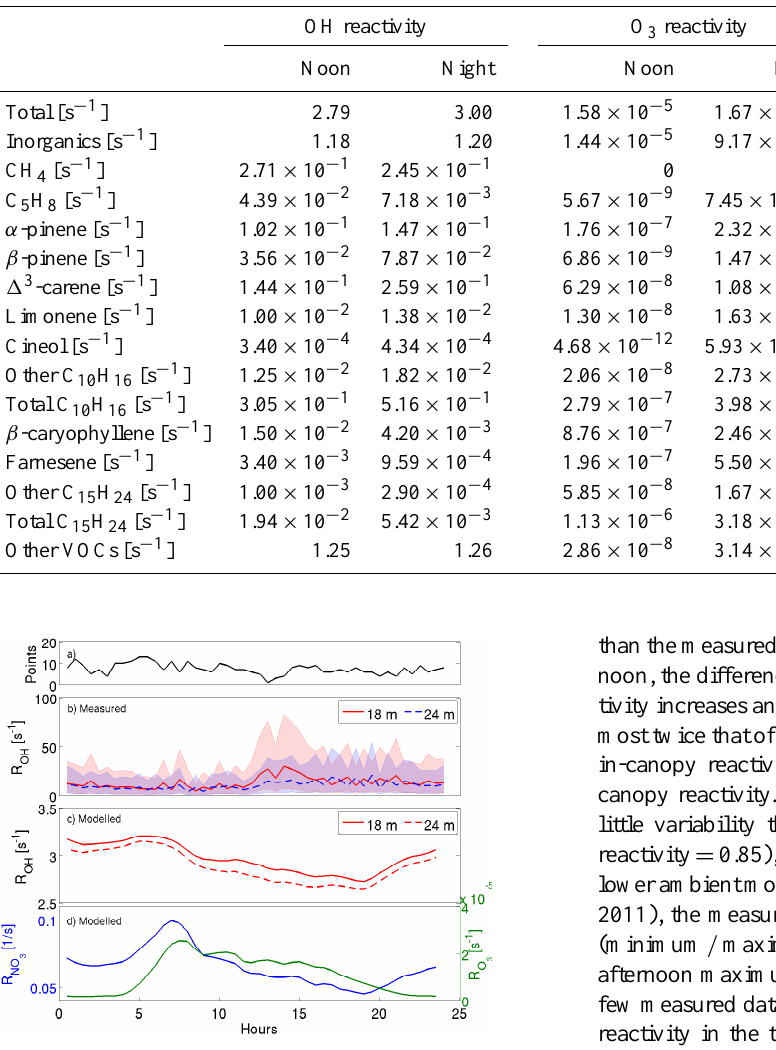
Figure 7. Daily averaged measured and modelled total OH-reactivity together with daily averaged Figure 9. Daily averaged measured and modelled total OH reactiv- modelled total O 3 - and NO 3 -reactivity. (a) indicates the amount of measured half hour data points that has been used for the averaging of the measured reactivity, (b) measured OH-reactivity at 18 ity together with daily averaged modelled total O 3 and NO 3 reactiv- (solid red line) and 24 m (dashed blue line), where the shaded areas are the 75 and 25 percentiles, ity. (a) indicates the number of measured half hour data points that (c) modelled OH-reactivity at 18 m (solid red line) and at 24 m (dashed red line), and (d) modelled reactivities of NO 3 (blue line, left sided y axis) and O 3 (green line, right sided y axis). has been used for the averaging of the measured reactivity, (b) mea- sured OH reactivity at 18 (solid red line) and 24m (dashed blue line), where the shaded areas are the 75 and 25 percentiles, (c) mod- elled OH reactivity at 18m (solid red line) and at 24m (dashed red line) and (d) modelled reactivities of NO 3 (blue line, left-hand side on y axis) and O 3 (green line, right-hand side on y